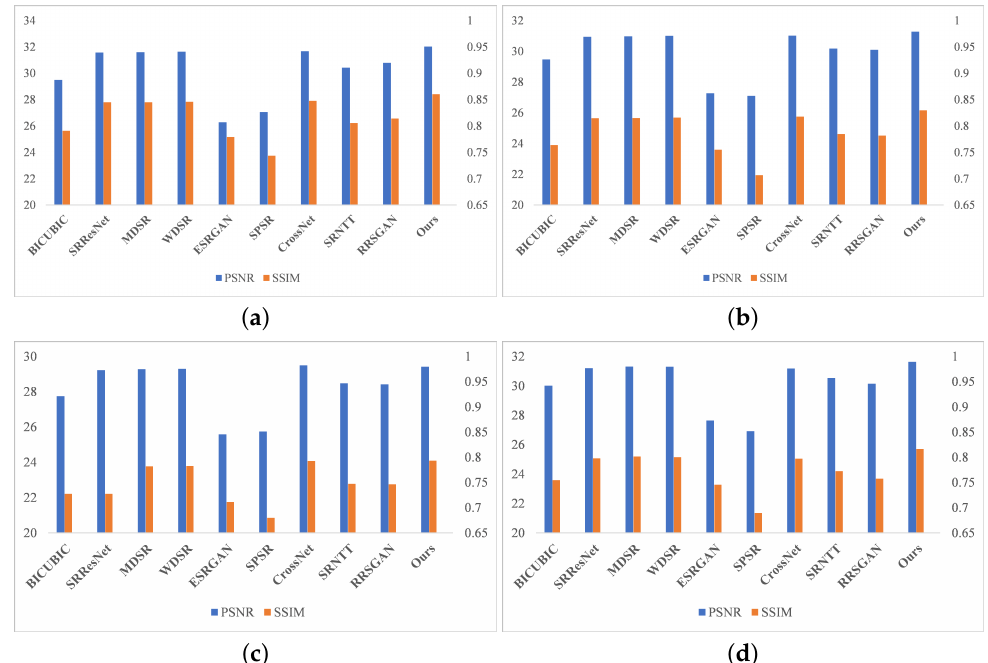
Figure 6. Visualization results of average PSNR and SSIM values for diverse SR methods of ×4 factor. ( a ) PSNR and SSIM on 1st test set; ( b ) PSNR and SSIM on 2nd test set; ( c ) PSNR and SSIM on 3rd test set; ( d ) PSNR and SSIM on 4th test